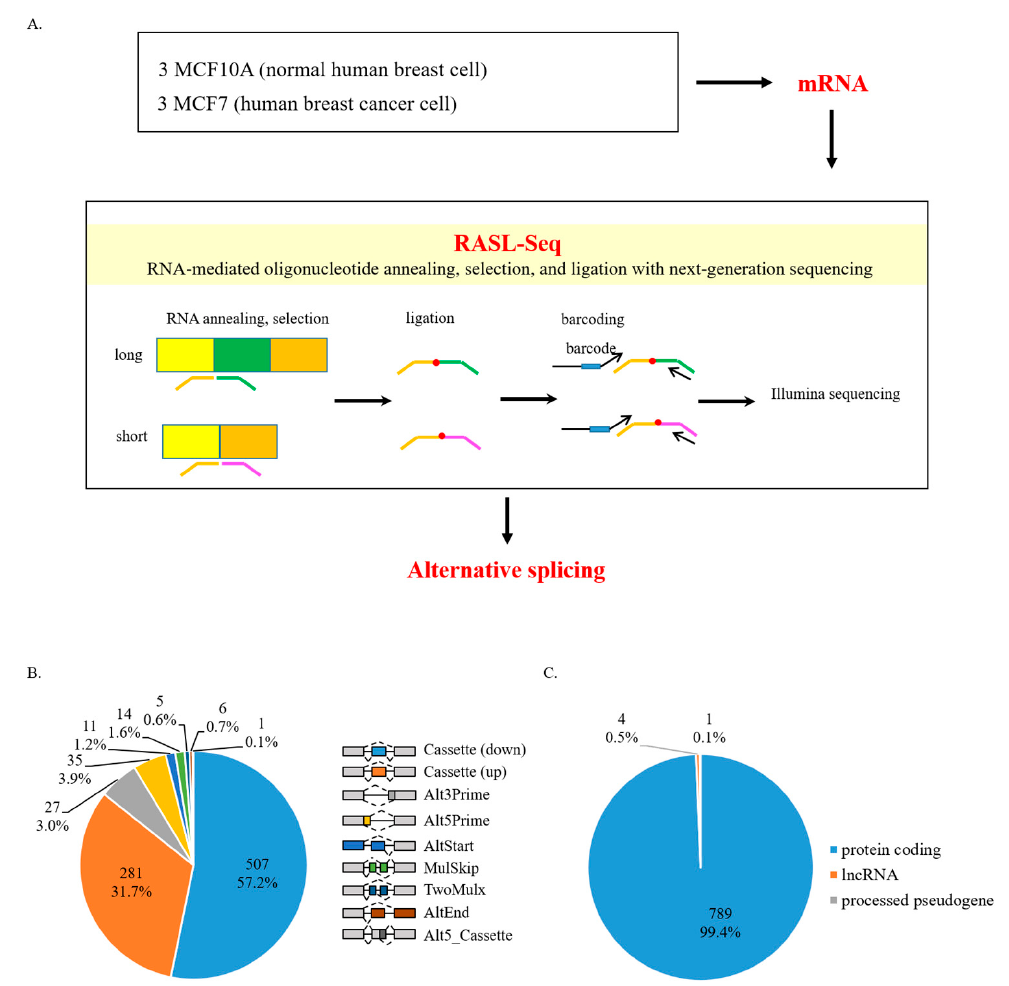
Figure 1. Pre-mRNAs undergo altered AS in human breast cancer cells. ( A ) Schematic representation of the RASL-seq technique using RNA extracted from human breast cancer cells (MCF7) and normal breast cells (MCF10A). ( B ) Pie chart showing different AS events from RASL-seq results. All events listed are drawn in the right. ( C ) Gene distribution of our RASL-seq results.